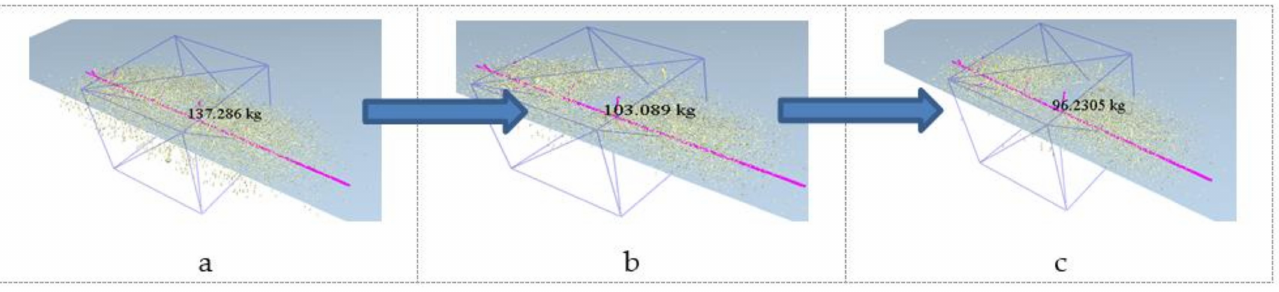
Figure 18. Simulation process of airduct mouth direction angle, 30 ◦ . ( a ) soil ridge mass at 0.5 s/(kg), ( b ) soil ridge mass at 1.5 s/(kg), ( c ) soil ridge mass at 2